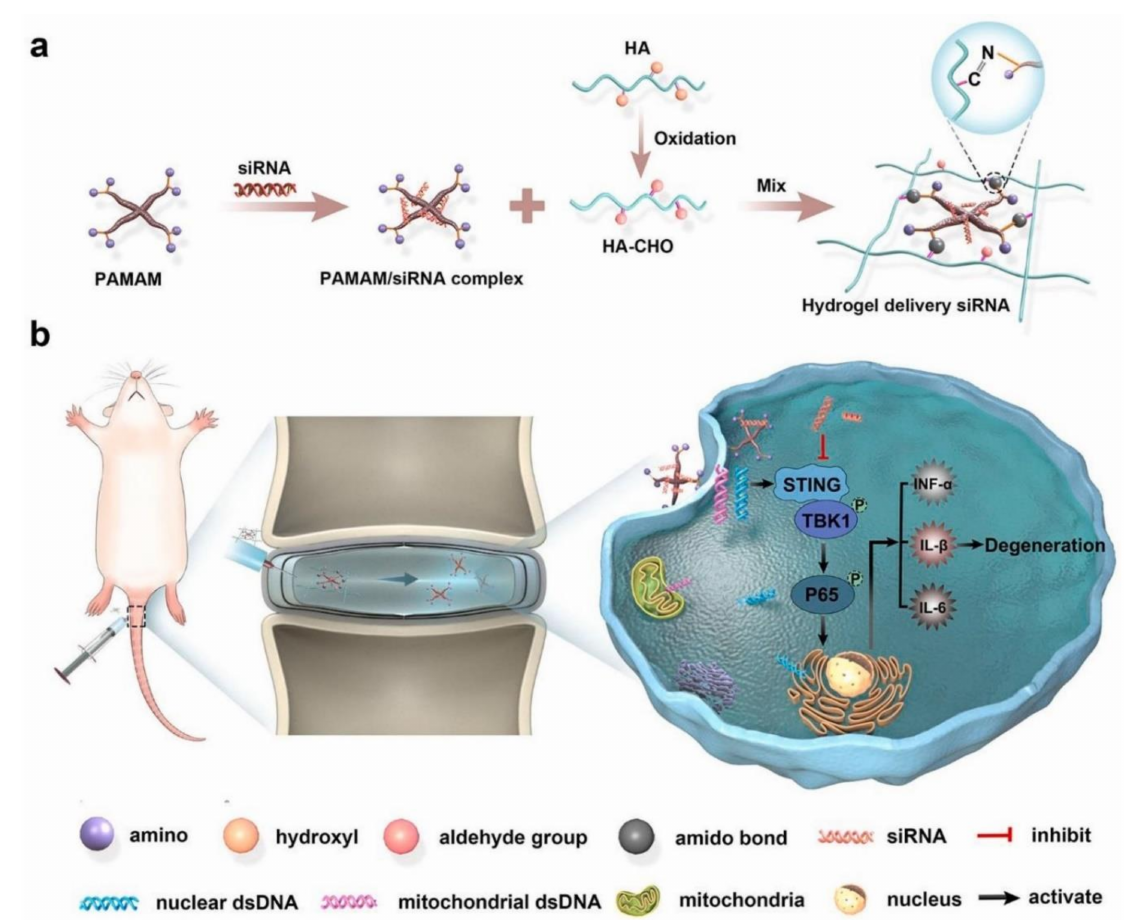
Figure 6. Schematic representation of the delivery system created by Chen et al. ( a ) Formation mechanism of the self-healing hydrogel with siRNA releasing property. ( b ) Mechanism of action against IDD. Reprinted from an open access source